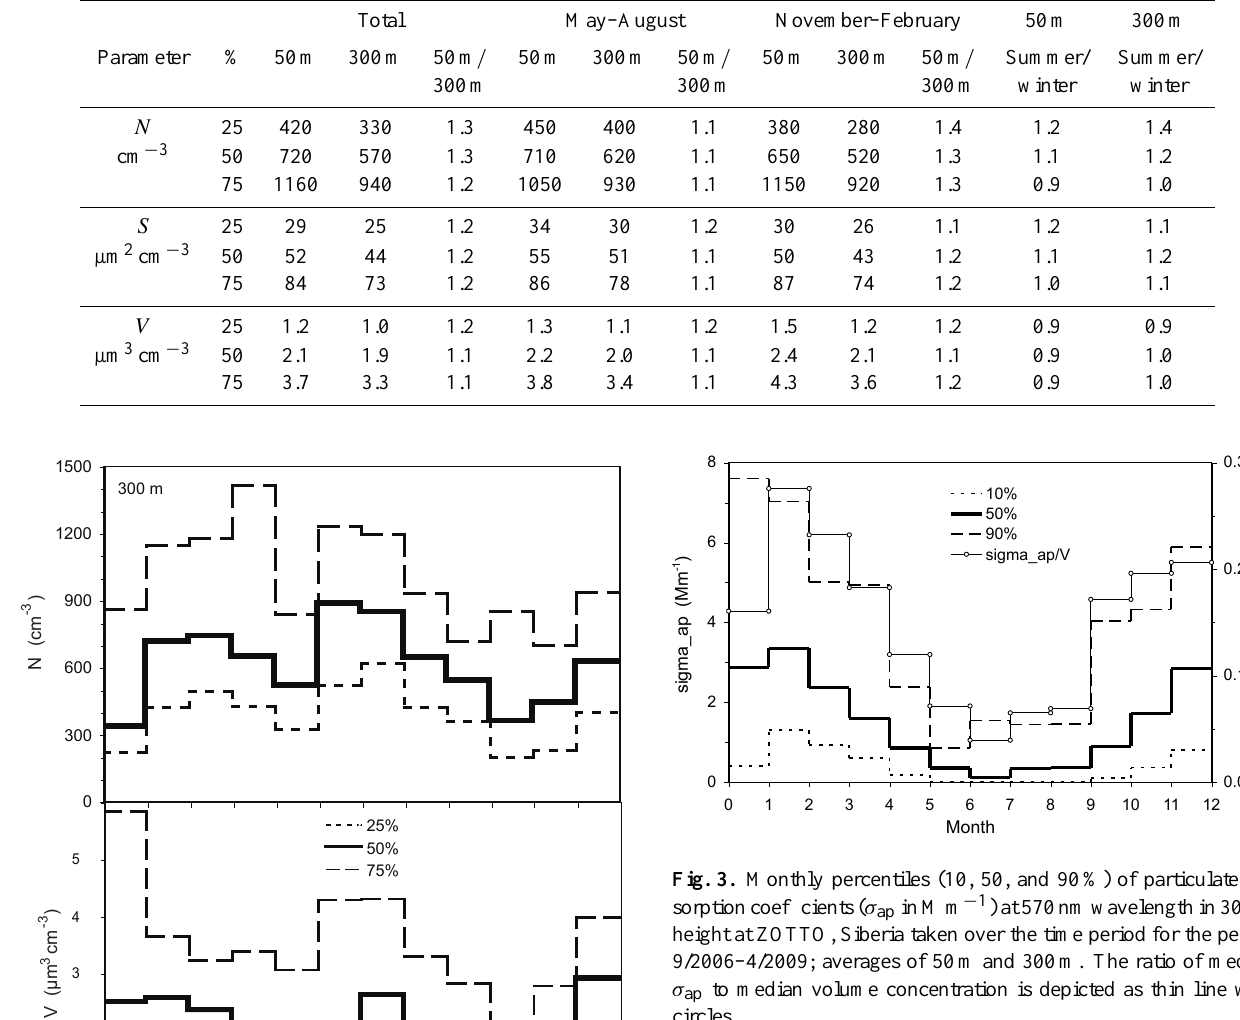
Table 1. 25th, 50th, and 75th percentiles of number ( N ), surface ( S ), and volume ( V ) concentrations at 50and 300m height at ZOTTO, Siberia. The statistics are given as total, for the summer months May–August, and for the winter months November–February. Ratios 50m / 300m and summer/winter are added.